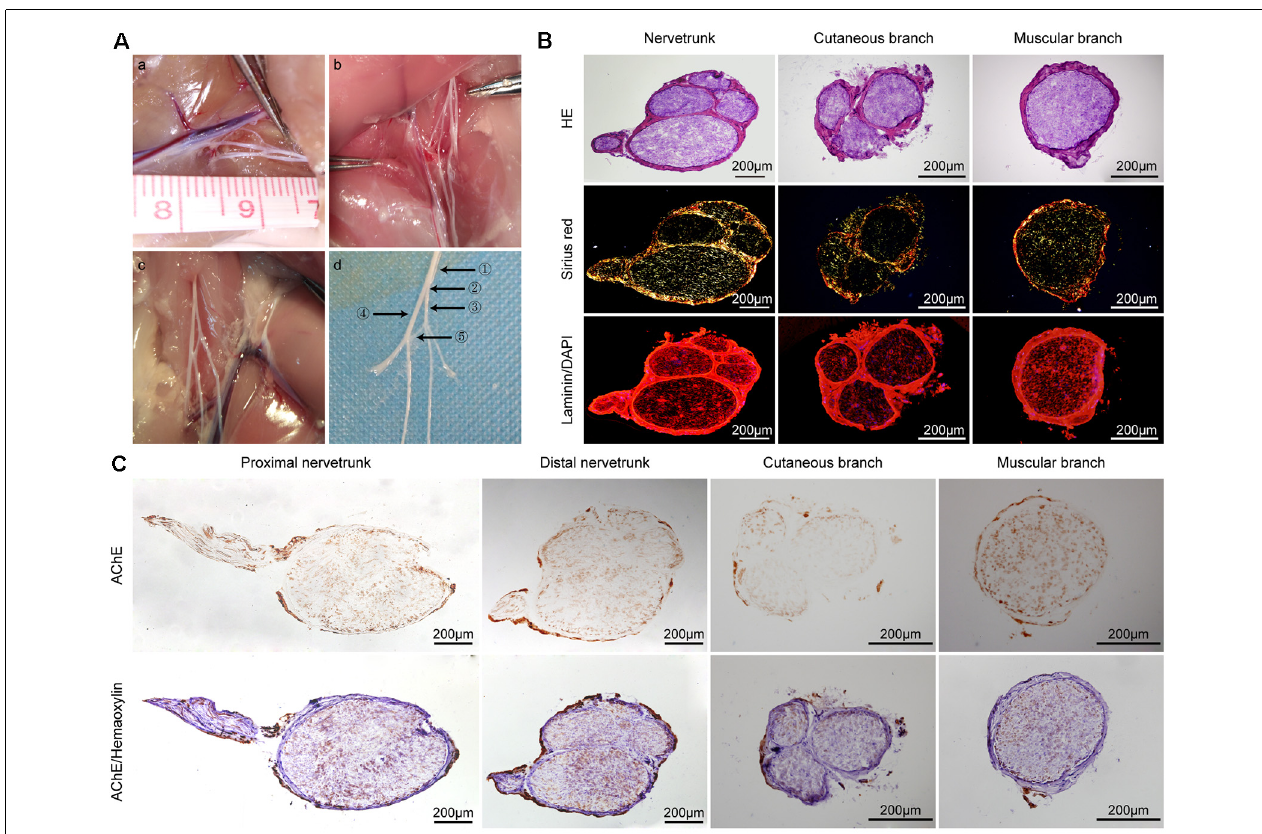
FIGURE 1 | General observations and histological evaluation of the femoral nerve of rats. (A) General view of variant femoral nerves of rats. The different types of variant femoral nerves (a–c) and a magnified anatomical drawing (d) of graph (c). (cid:172) : proximal nerve trunk (cid:173) : distal nerve trunk (cid:174) : cutaneous branch (cid:175) : muscular branch (cid:176) : variant branch (B) Hematoxylin and eosin (H&E), Sirius Red, and laminin (red)/DAPI (blue) staining of the nerve trunk, cutaneous branch, and muscular branch of a normal rat femoral nerve, respectively. (C) Acetylcholinesterase (AChE) staining of the proximal nerve trunk, distal nerve trunk, cutaneous branch, and muscular branch of a rat normal femoral nerve; upper row is AChE staining only and the lower row is AChE and hematoxylin